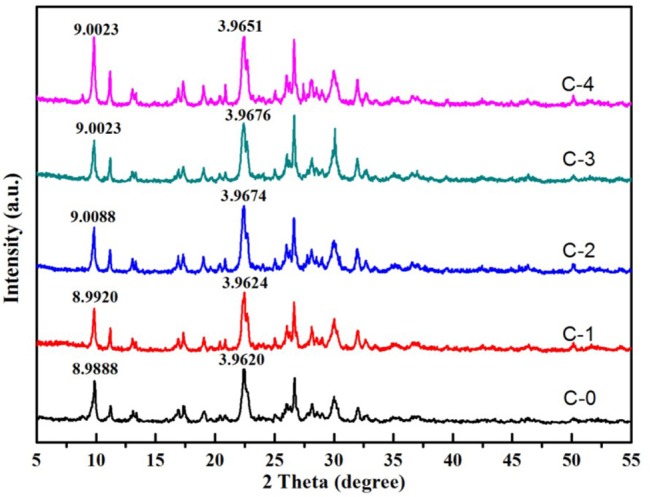
XRD of clinoptilolites.